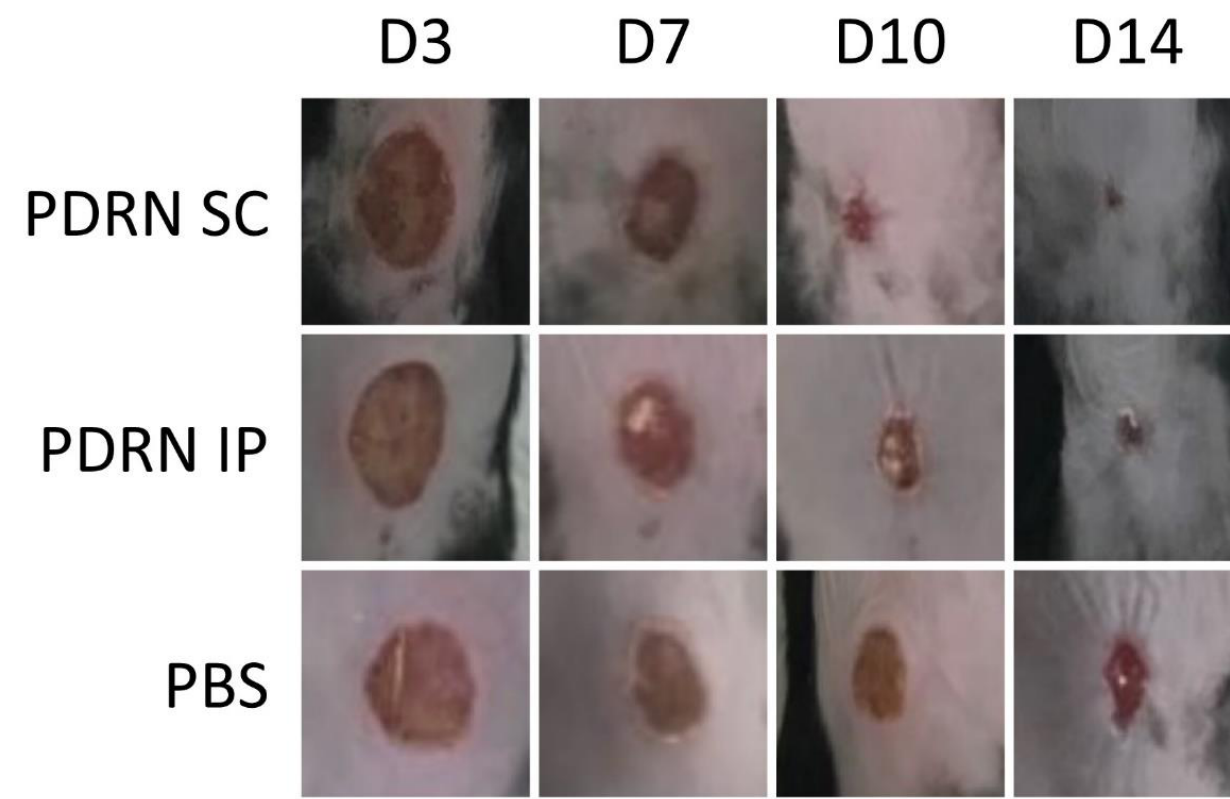
Figure 1. Gross examinations of the diabetic wounds were performed at 3, 7, 10 and 14 days. Then, time-dependent changes in the diameter of the diabetic wounds were monitored. At 10 days, the PDRN SC group showed a significantly smaller diameter of diabetic wounds as compared with the PBS group (2.1 ± 0.1 versus 4.87 ± 0.38 mm, respectively; p = 0.0024). Likewise, the PDRN IP group also showed a significantly smaller diameter of diabetic wounds as compared with the PBS group (2.5 ± 0.3 versus 4.87 ± 0.38 mm, respectively; p = 0.0053) (Figure